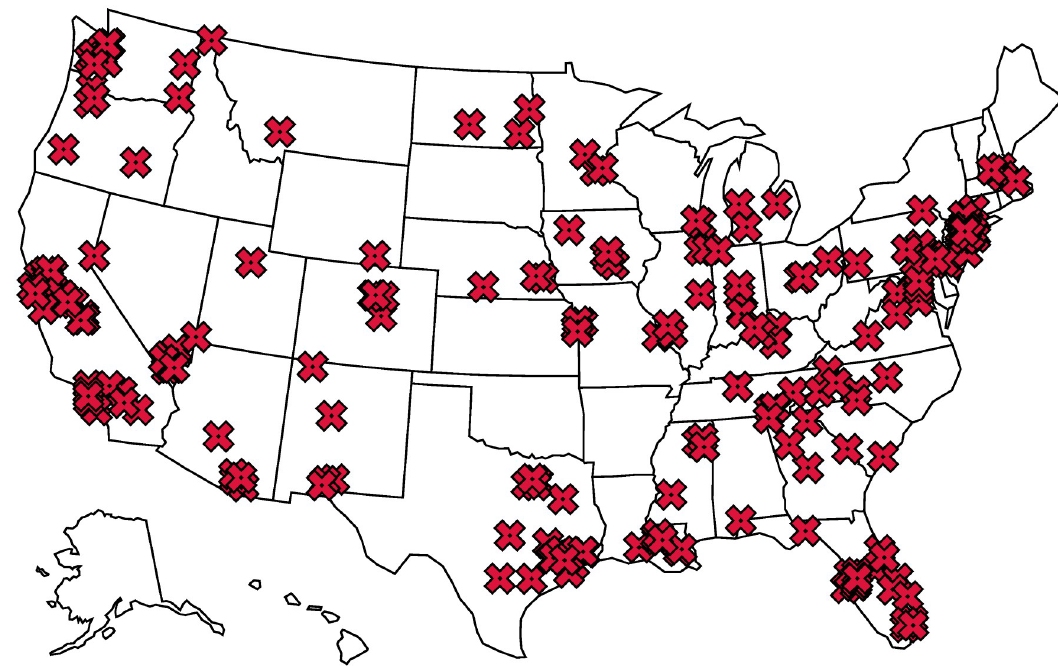
Fig 2. Overview of feature extraction and representation. Textual themes and CAMEO events from the Global Knowledge Graph and Events Database, respectively, were used to generate daily observations about each state. The ensemble methods learned from a moving average representation ( Δ t and Δ t � ) of the daily observations, and the neural network methods learned from a stacked representation. A red X indiciates an event (terrorist attack) while a white circle indicates a non-event (absence of terrorist attack), and each color represents a unique news